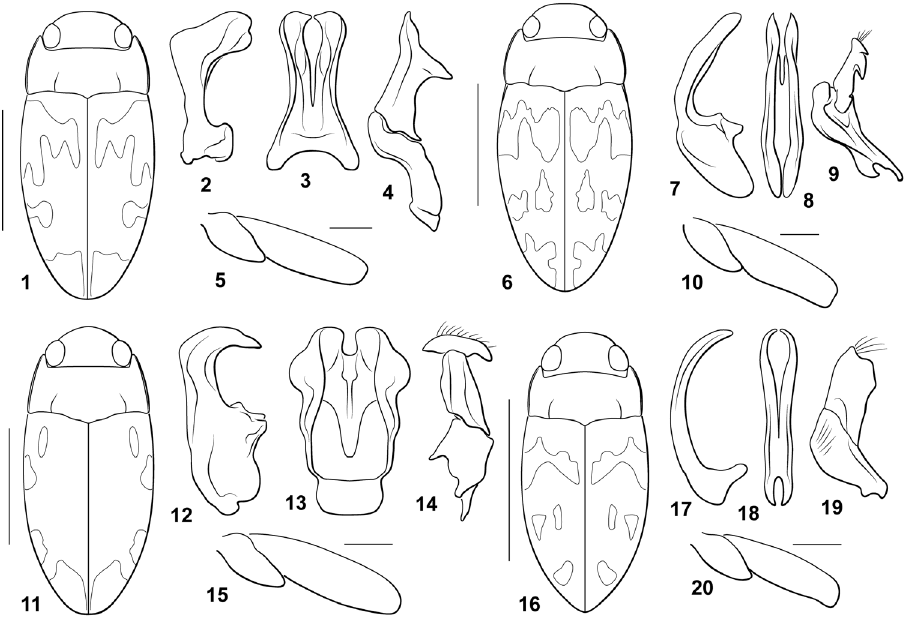
Figures 1–20. Bidessodes species. 1–5 B. chlorus 1 dorsal habitus, scale = 1 mm 2–4 male genitalia 2 median lobe, right lateral aspect 3 median lobe, ventral aspect 4 right lateral lobe, right lateral aspect 5 left metatrochanter and metafemur, anterior aspect, scale = 0.25 mm 6 B. erythros 6 dorsal habitus, scale = 1 mm 7–9 male genitalia 7 median lobe, right lateral aspect 8 median lobe, ventral aspect 9 right lateral lobe, right lateral aspect 10 left metatrochanter and metafemur, anterior aspect, scale = 0.25 mm 11 B. leukus 11 dorsal habitus, scale = 1 mm 12–14 male genitalia 12 median lobe, right lateral as- pect 13 median lobe, ventral aspect 14 right lateral lobe, right lateral aspect 15 left metatrochanter and metafemur, anterior aspect, scale = 0.25 mm 16 B. melas 16 dorsal habitus, scale = 1 mm 17 male geni- talia 17 median lobe, right lateral aspect 18 median lobe, ventral aspect 19 right lateral lobe, right lateral aspect 20 left metatrochanter and metafemur, anterior aspect, scale = 0.25 mm. (Fig. 1) very broadly curved laterally; shiny, finely microreticulate across surface, ir- regularly and inconsistently micropunctate. Prosternal process elongate triangular, ba- sally broad and posteriorly convergent to sharply pointed apex; surface weakly convex. Metaventrite process anteriorly produced with weak lateral carinae that do not extend posteriorly; surface of metaventrite smooth and shiny, not carinate or otherwise modi- fied. Metacoxa with lateral portions shiny, not punctate; metacoxal lines elongate, sub- parallel. Abdominal ventrites smooth, impunctate; ventrite VI smooth, evenly convex, apically